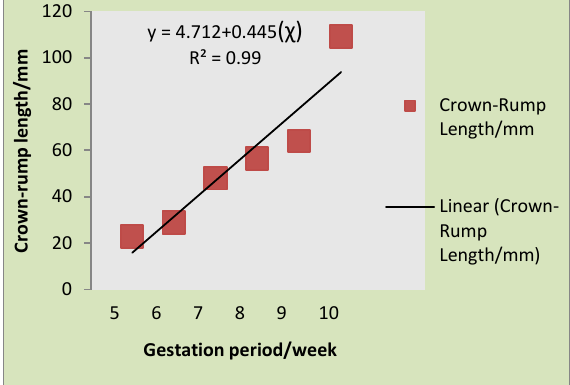
Figure, 11: Relationship between CRL (mm) and gestation age